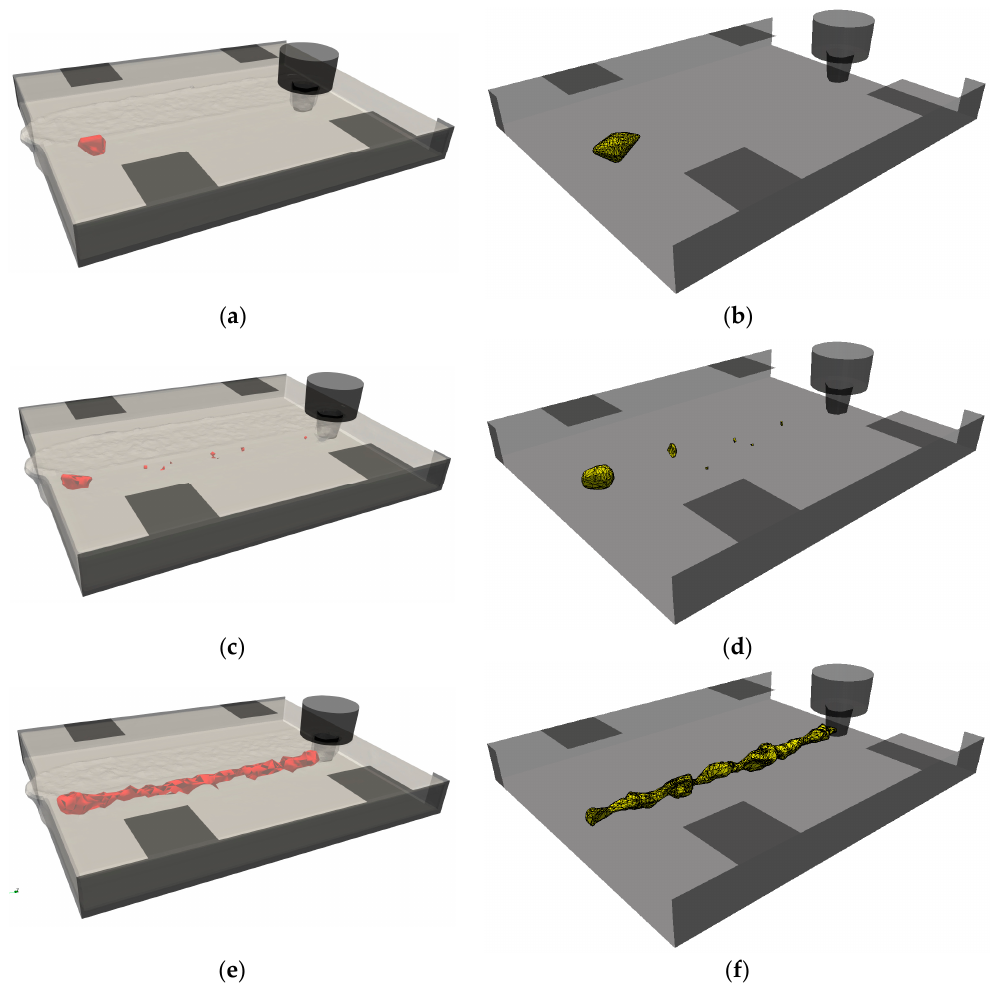
Figure 10. Comparison of predicted and measured defects at the end of the advancing phase: ( a , b ) show 0.38 weld pitch, ( c , d ) show 0.84 weld pitch, ( e , f ) show 1.34 weld pitch. Table 8. Defect volume comparison between simulation and